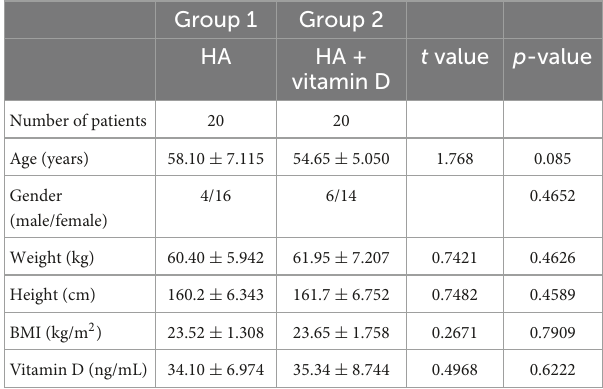
TABLE 2 Demographic data of HA-injected patients with or without vitamin D